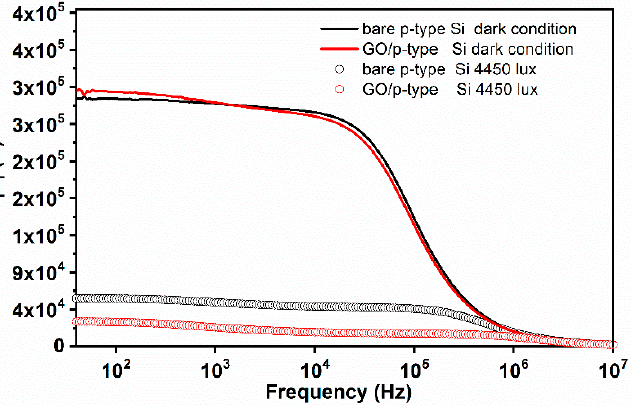
Figure 8. Impedance measurements on p-type silicon and graphene oxide/p-type Si samples under dark and light illumination conditions.